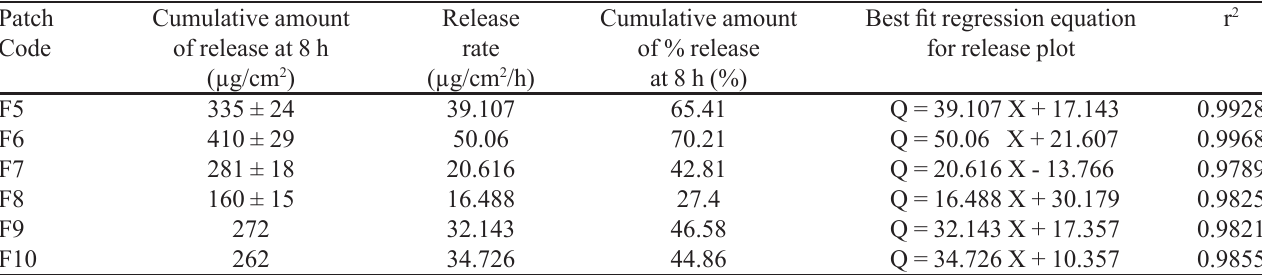
TABLE III - Release parameters of glipizide from various patches Patch